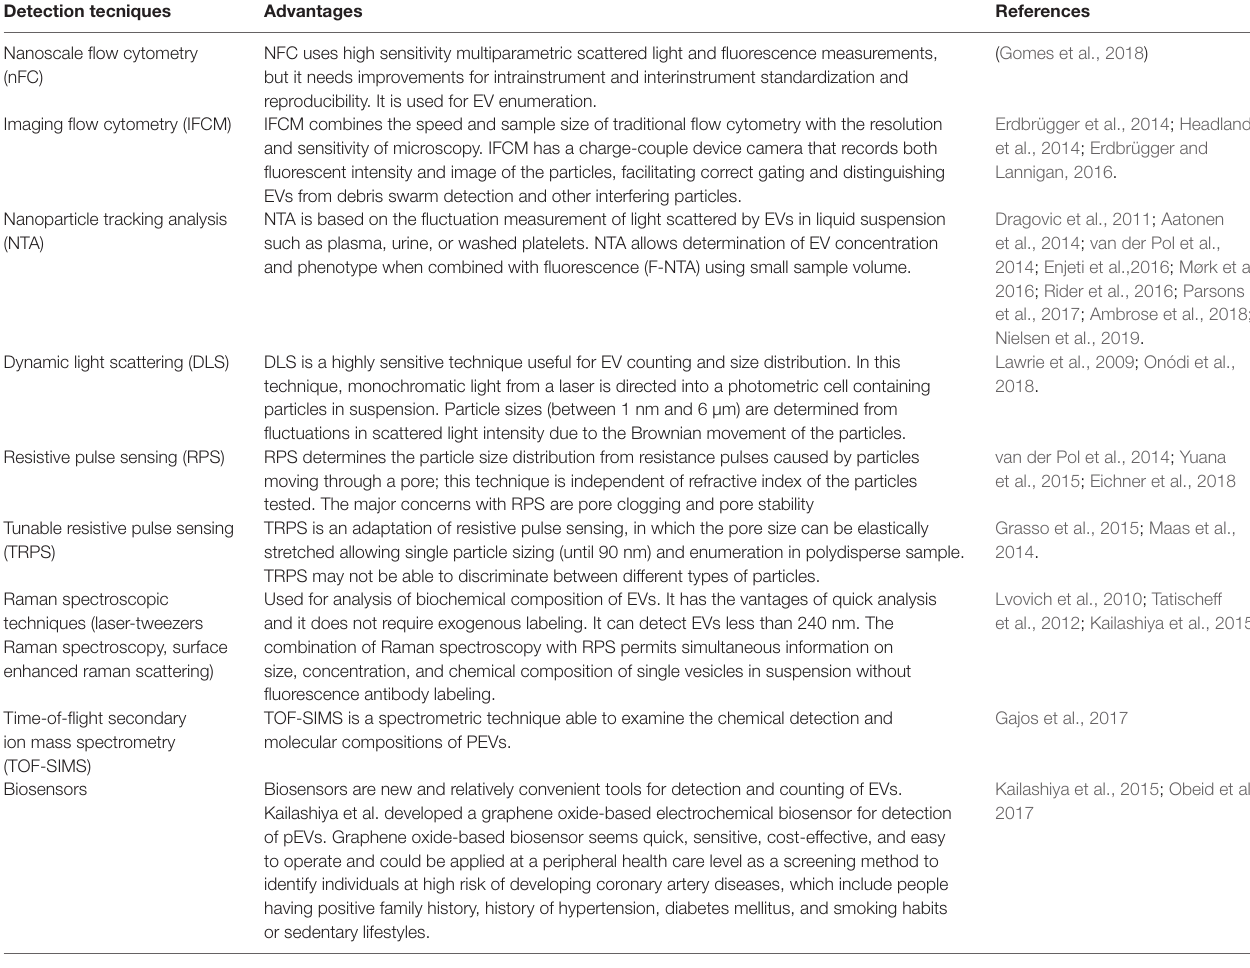
TABLE 1 | Innovative techniques potentially useful for the detection and quantification of platelet-derived extracellular vesicles